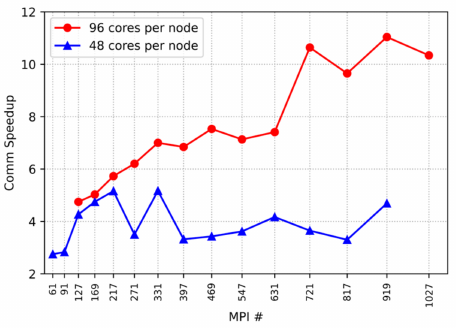
Figure 8. Speedup of communication